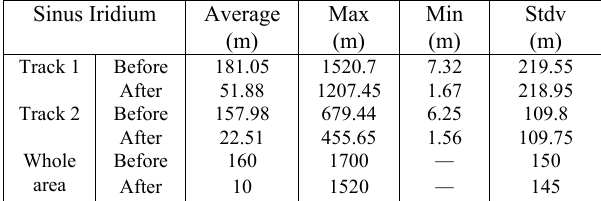
Table 2. Statistical data for each track and the whole area of 2D grey-scale images at Sinus Iridium area before and after Least Squares Matching